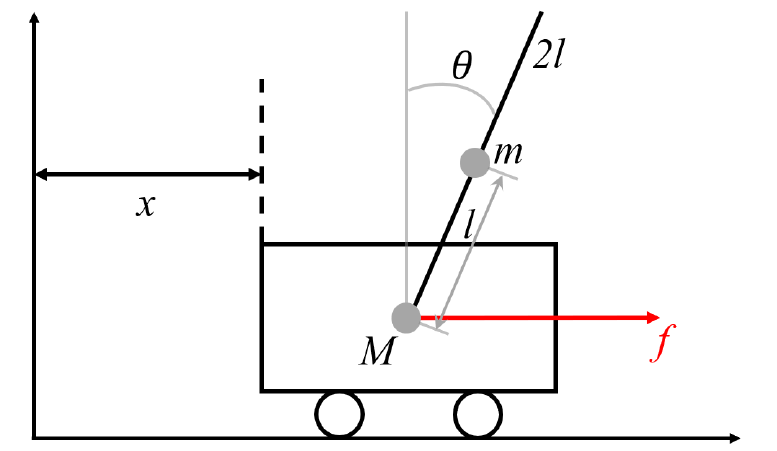
Figure 1. Inverted pendulum model. Figure 1 introduces the following symbols: m —pendulum mass; M —carriage mass; f —force applied by the motor to the carriage through the belt; 2 l —pendulum length; l —distance from the pivot point to the center of mass of the pendulum; I —moment of inertia of the pendulum; θ ( t ) —the deviation angle of the pendulum from the vertical, in the position of unstable equilibrium is zero, increases clockwise; x ( t ) —carriage